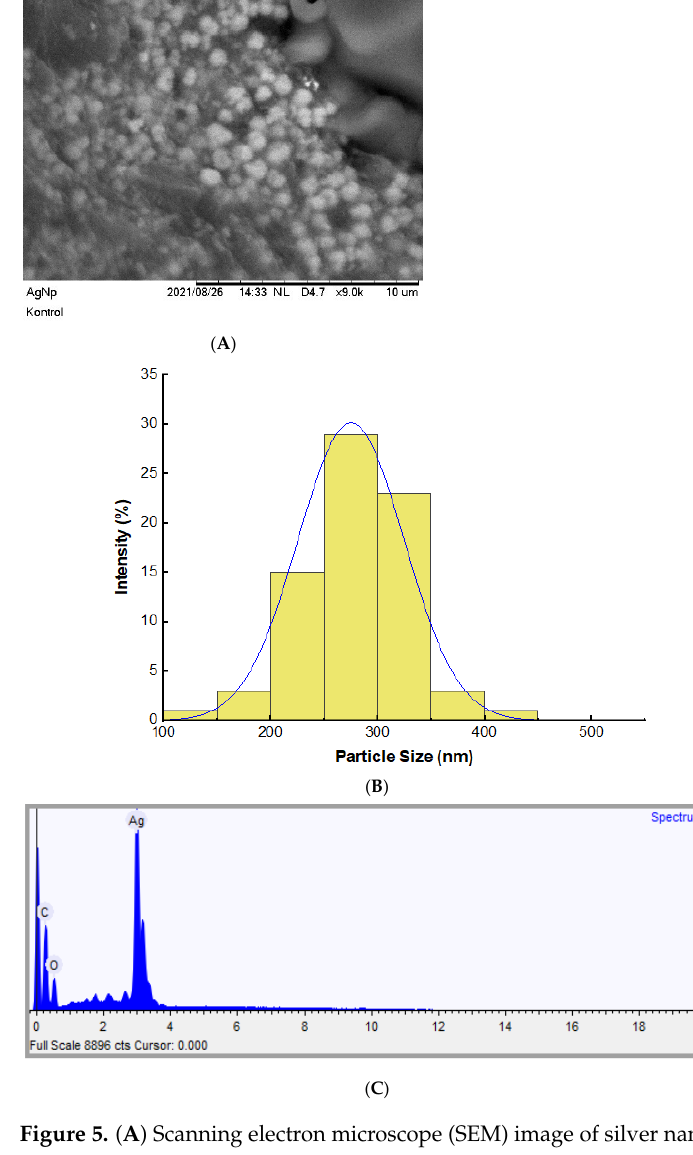
Figure 5. ( A ) Scanning electron microscope (SEM) image of silver nanoparticles with 9000× multiplication; ( B ) Particle size distribution of silver nanoparticles; ( C ) EDX spectra of silver